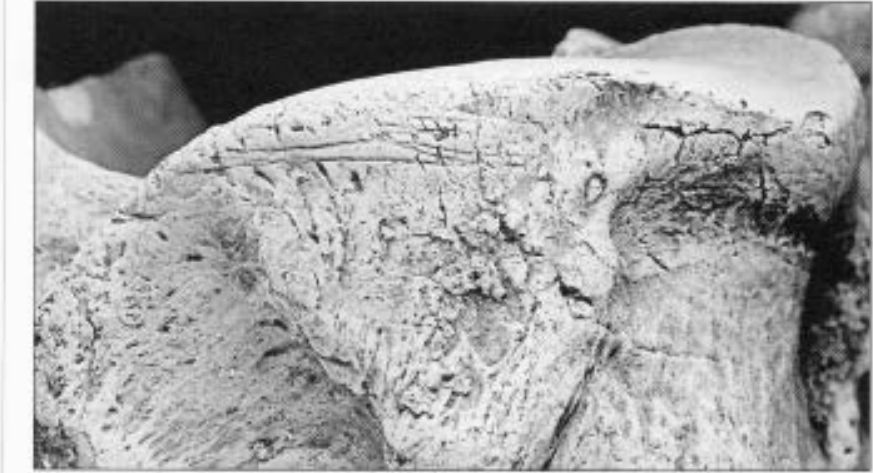
Figure 3 Detail of the left hind foot bone (navicular-cuboid) of a bison from the Forest­ bed at Happisburgh, collected by A. C. Savin and now in the Natural History Museum, London (accession number M6583). It shows parallel cut marks on the lateral face just